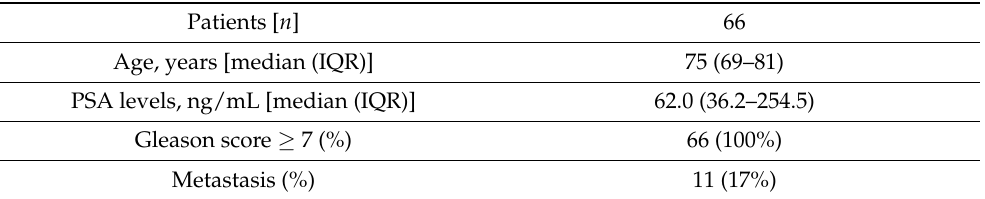
Table 1. Demographic, biochemical, and clinical parameters of patients with significant PCa. PSA: Prostate-specific